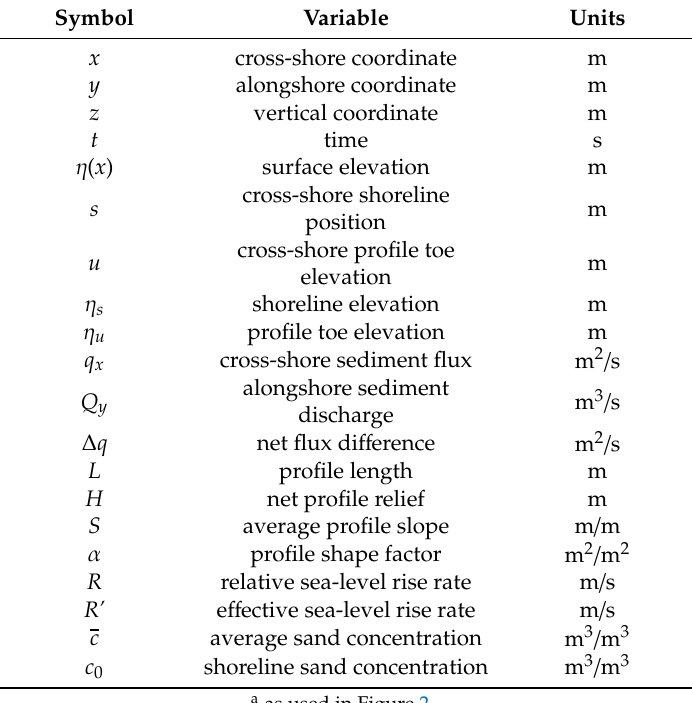
Table 1. Shoreline sediment conservation equation parameters a .